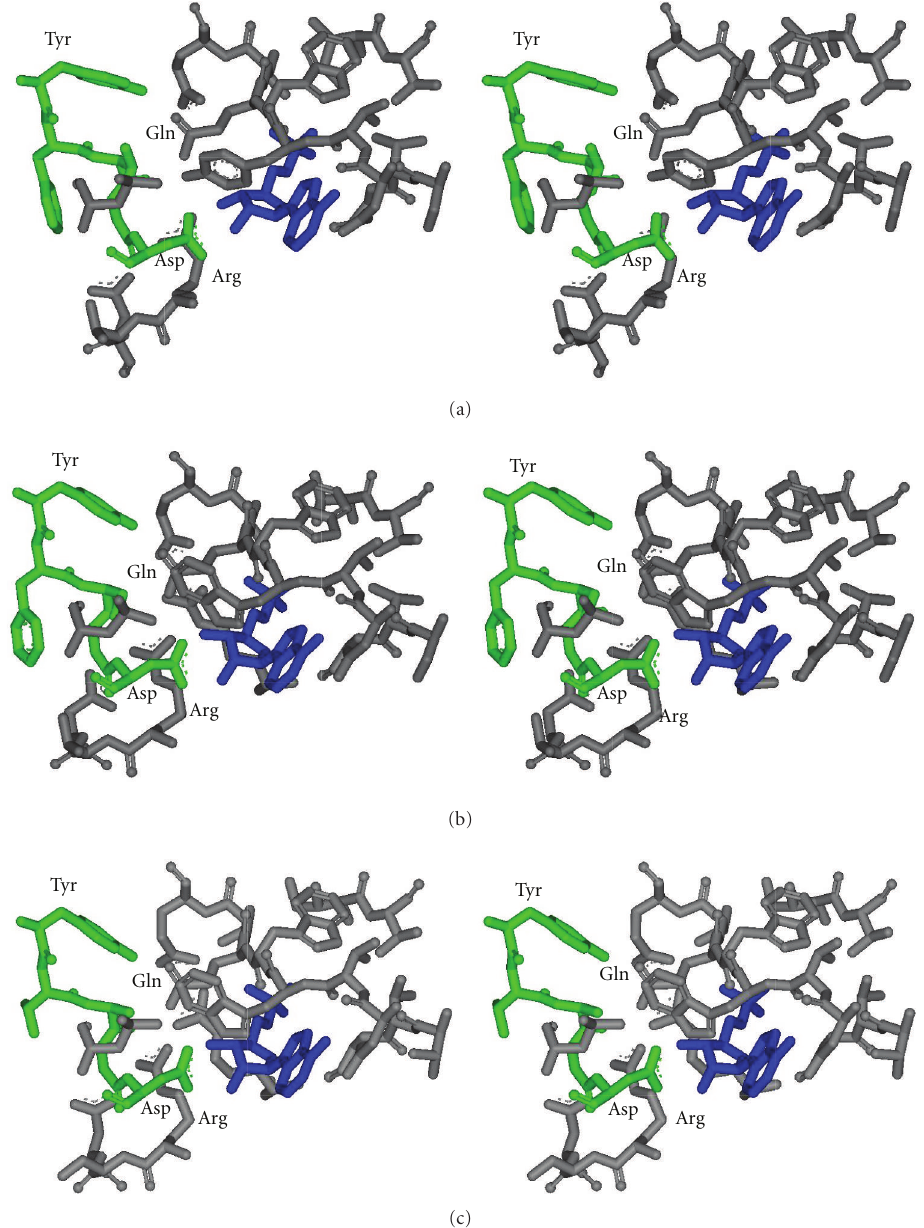
Figure 1: Position of motif III residues in the active sites of (a) Acs Sc , (b) Acs Se , and (c) the Acs1 Mt structural model. Acs1 Mt modeled on the Acs Se structure (PDB:2P2F) using Accelrys DS Modeler and the stereo images were created using Accelrys DS ViewerPro 5.0. For clarity in viewing, only some residues within the 10 ˚A sphere of AMP are shown. AMP is shown in blue, and the motif III residues are shown in green. Residues discussed in the text are